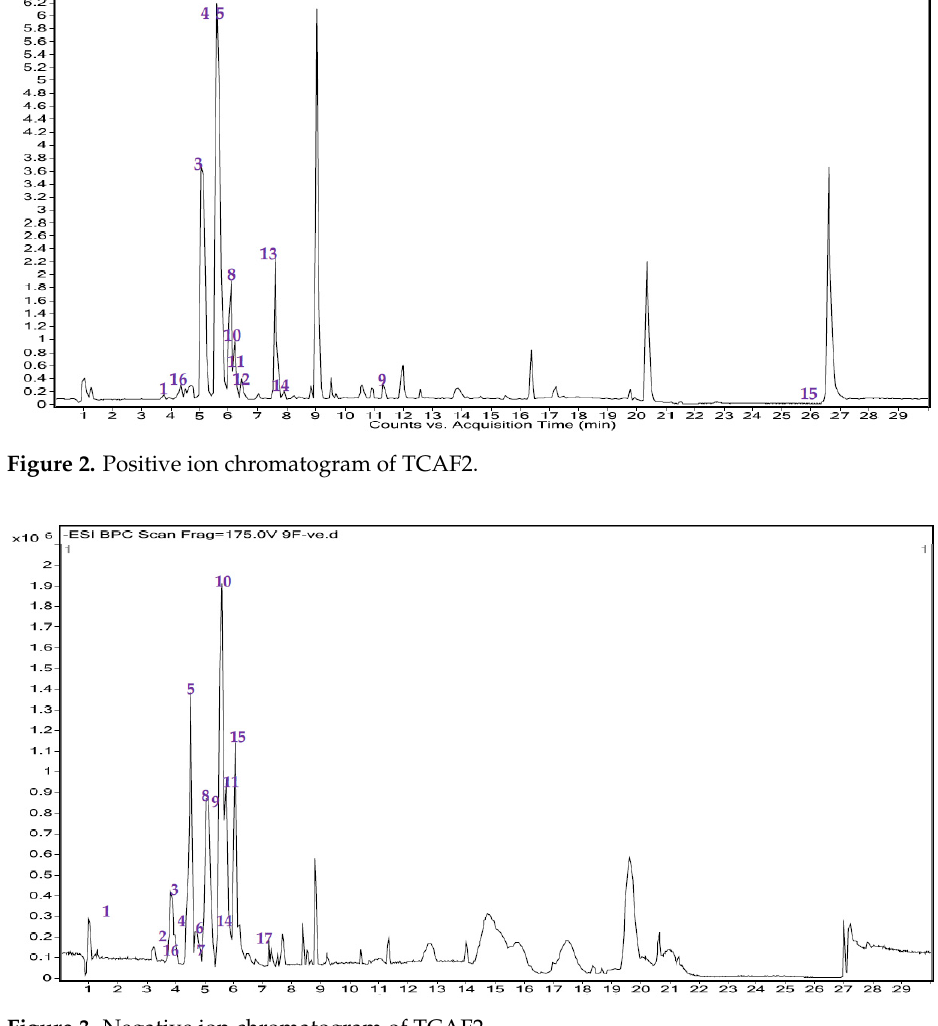
Figure 3. Negative ion chromatogram of TCAF2.